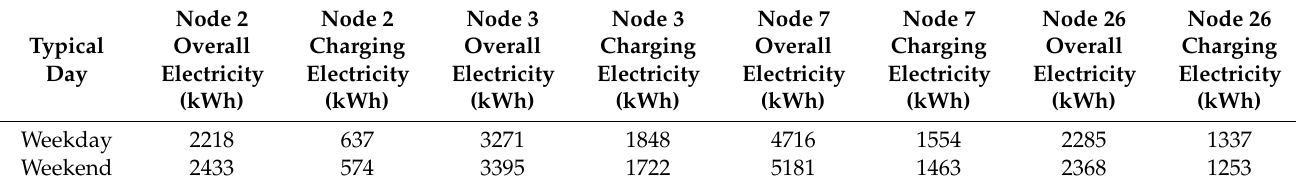
Table 4. Comparison of charging power of access